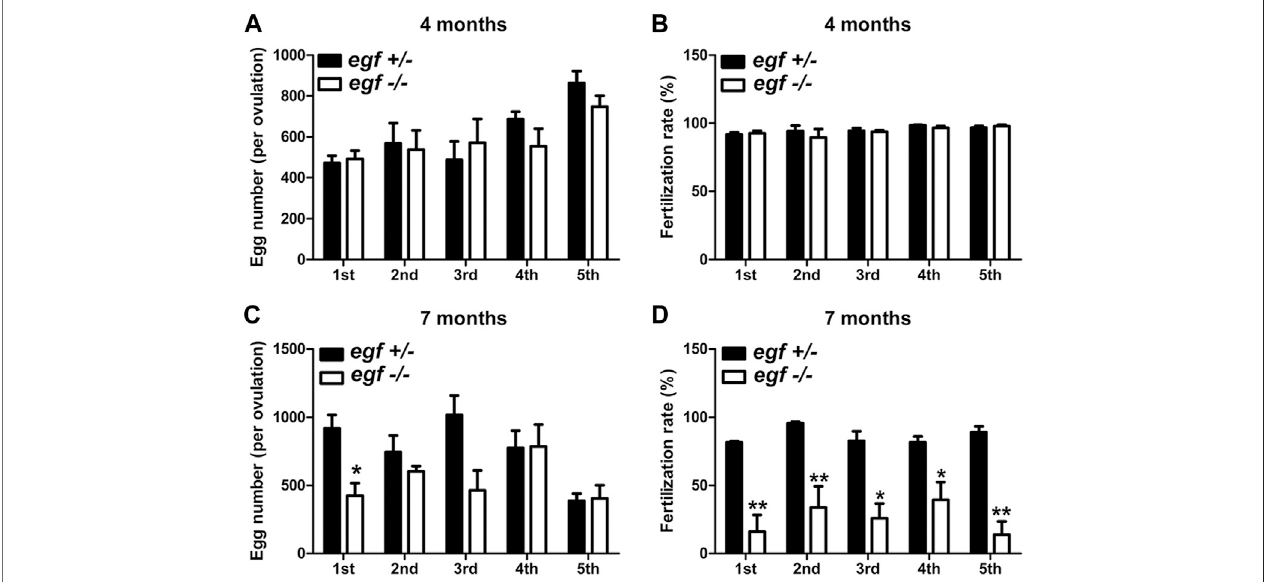
FIGURE 4 | Reproductive performance of egf mutant at 4 and 7 mpf. (A) Egg numbers at 4 mpf in fi ve fecundity tests (1st – 5th). (B) Fertilization rates in fi ve spawning tests at 4 mpf. (C) Egg number per spawning at 7 mpf. (D) Fertilization rate at 7 mpf. * p < 0.05; ** p < 0.01 ( n (cid:1) 5 per test).